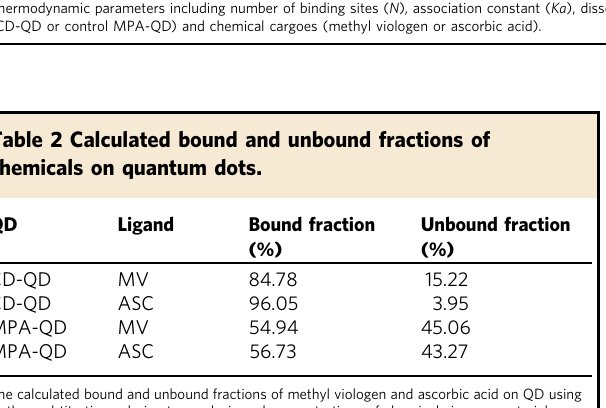
The calculated bound and unbound fractions of methyl viologen and ascorbic acid on QD using isothermal titration calorimetry analysis and concentrations of chemicals in nanomaterial